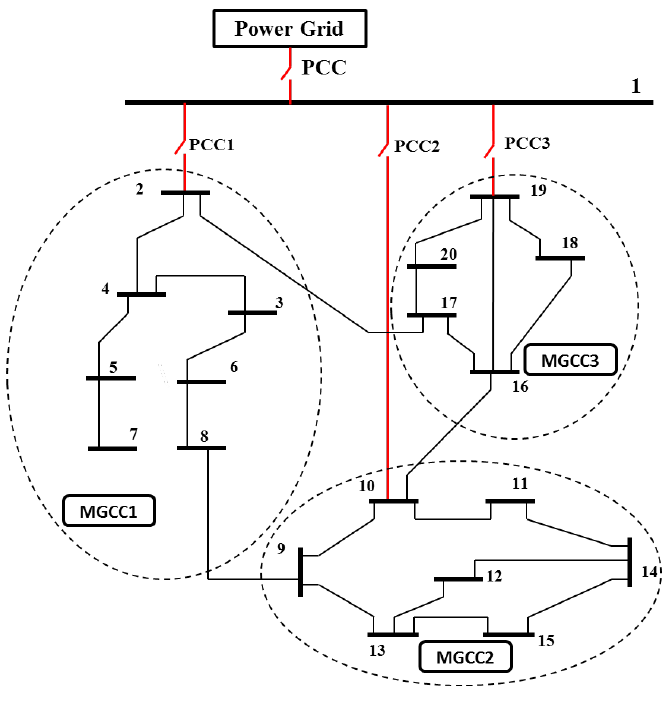
Figure 4. Integrated microgrids, from [22].